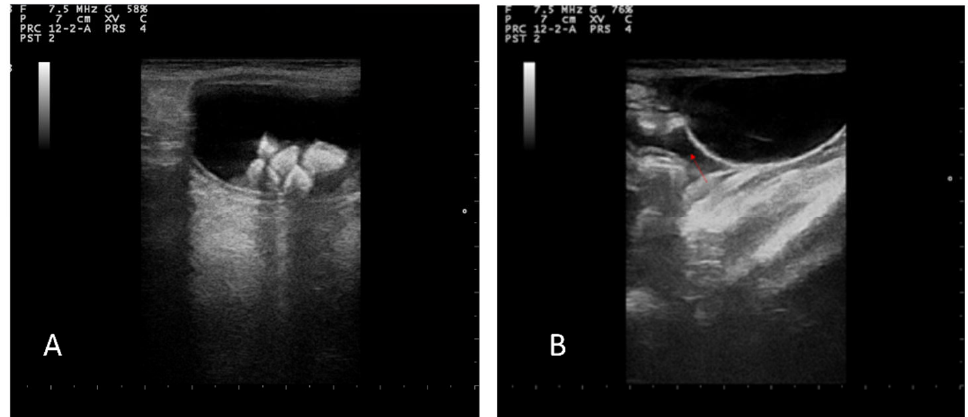
Figure 2. ( A ) Ultrasonographic images of urinary bladder lithiasis. ( B ) Free fluid in abdomen (red arrow).